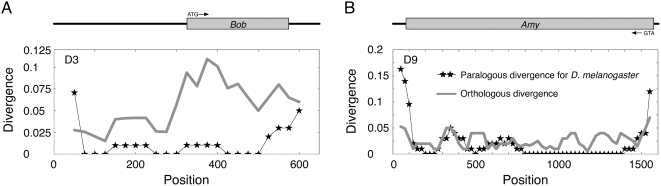
Distributions of the divergence between duplicated blocks, obtained by a window analysis with size 100 bp.(A) Pre6 block with the Bob genes. (B) Pre16 with the Amy genes.